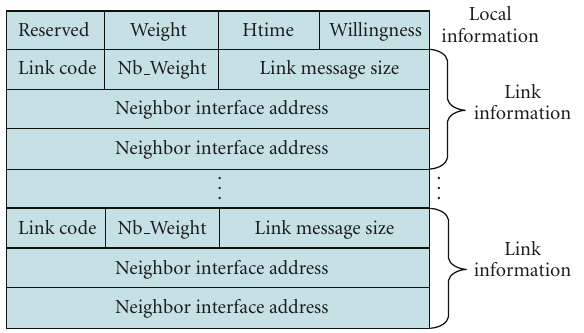
Figure 1: OLSR HELLO message formats modified to include weight information.